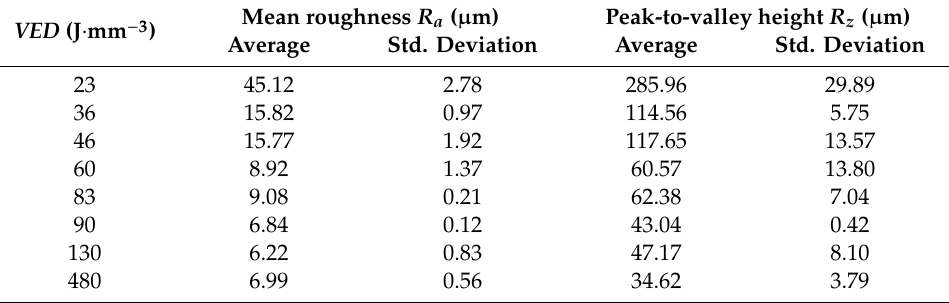
Table 2. Mean values of roughness with corresponding dispersion for each processing